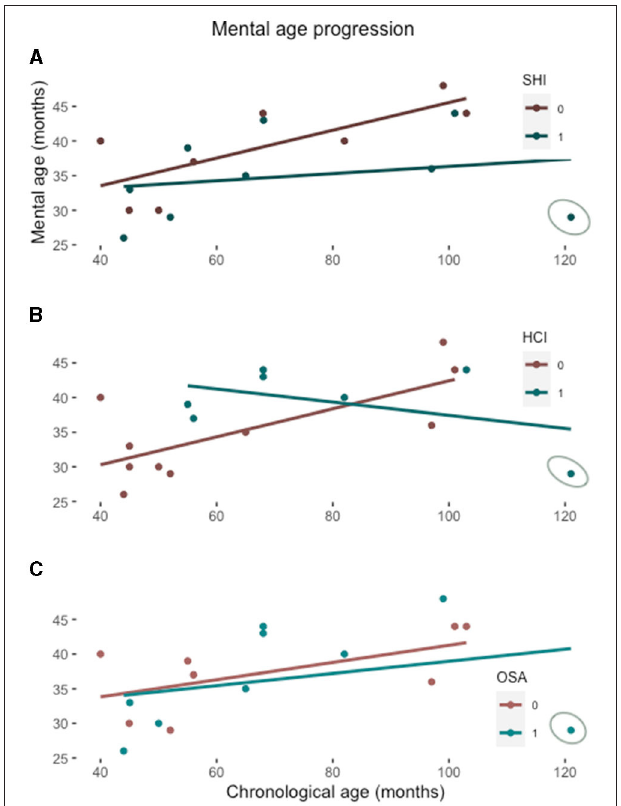
FIGURE 1 | Scatterplot showing the mental age relative to the chronological age in patients with and without a SHI (A) , with and without the history of cardiac interventions (HCI) (B) , and with and without OSA (C) . The lines represent the linear regression function for each subgroup. The patient with all three conditions overlapping is circled on each